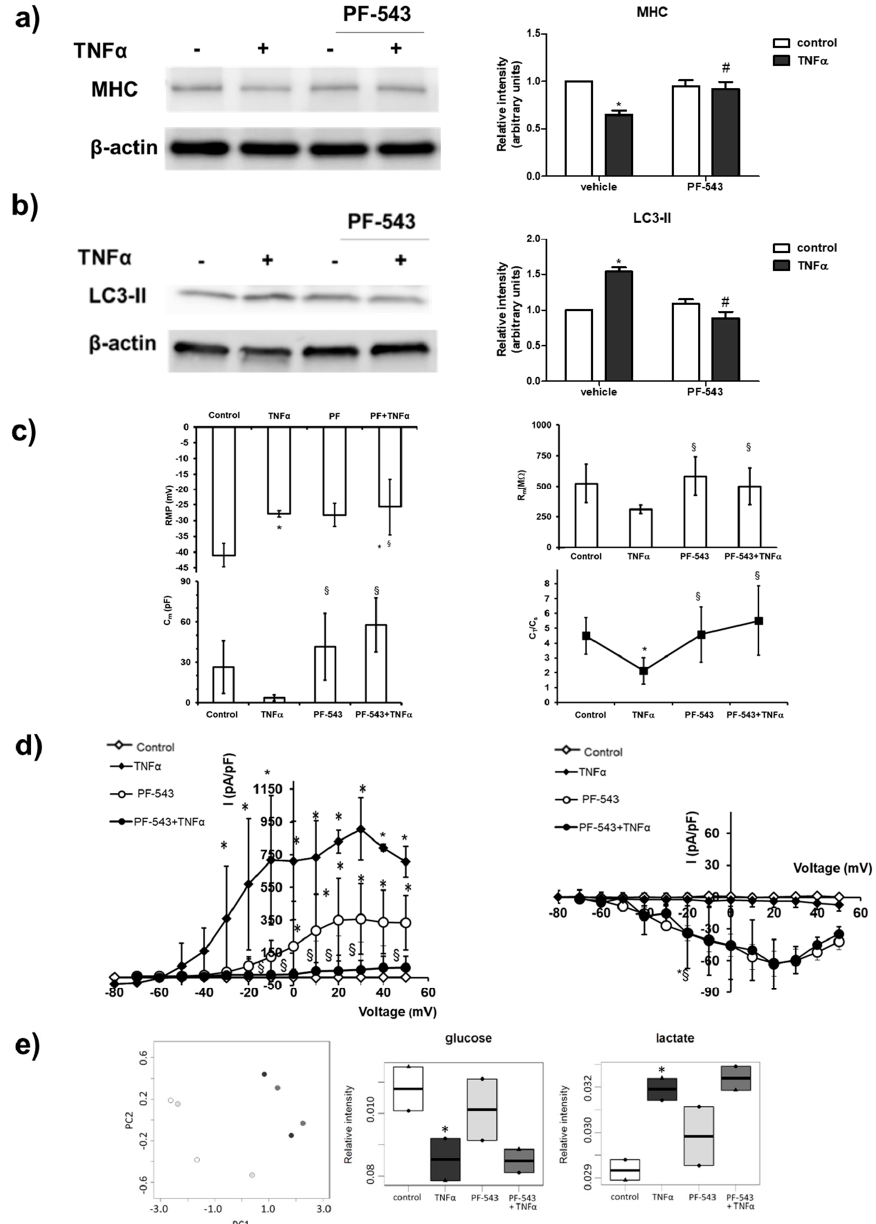
Figure 4. SK1 is involved in TNF α -induced effect in C2C12 myotubes. C2C12 myotubes were pre-treated with SK1 specific inhibitor PF-543 (10 µM) for 1 h before being challenged with 100 ng/mL TNF α for 24 h. The content of MHC ( a ) and LC3-II ( b ) was analyzed by Western blotting of whole cell lysates. A blot representative of three independent experiments with analogous results is shown. The histograms represent the densitometric analysis of at least three independent experiments; Data are the mean ± SEM and are reported as protein expression normalized to β -actin, -fold change over control (set as 1). The effect of SK1 inhibition by PF-543 on TNF α atrophic effect is statistically significant by two-way ANOVA followed by Bonferroni’s post hoc test (# p > 0.05). ( c ) RMP, R m , C m and C T /C s ratio in the different conditions. All of the results and number of cells investigated are listed in Table S1 as mean ± SD. * Indicates p < 0.05 vs. control; § indicates p < 0.05 vs. TNF α ; (One-way ANOVA and Bonferroni’s post hoc test). ( d ) Left panel: overall I–V plots related to K + currents measured in all of the experiments conducted in any conditions. * p < 0.05 vs. control, § p < 0.05 PF-543 + TNF α vs. TNF α (two-way ANOVA and Bonferroni’s post hoc test) ( n = 5 to 7 for the different treatments). Right panel: Overall I–V plots related to Ca 2+ currents measured in all